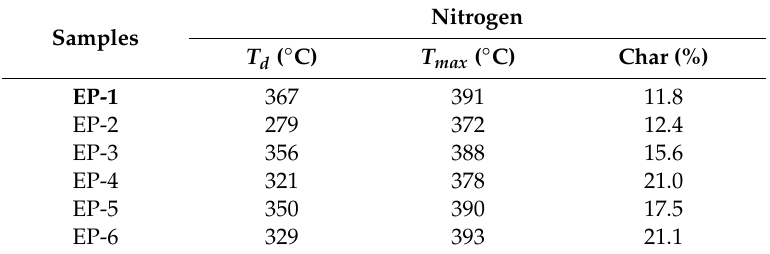
Table 2. TGA data for cured epoxy resin and its composites under N 2